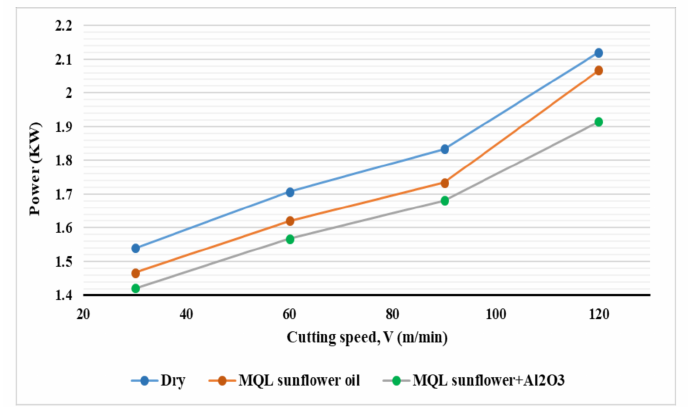
Figure 7. Effect of cooling strategies on power consumption with different cutting speeds.